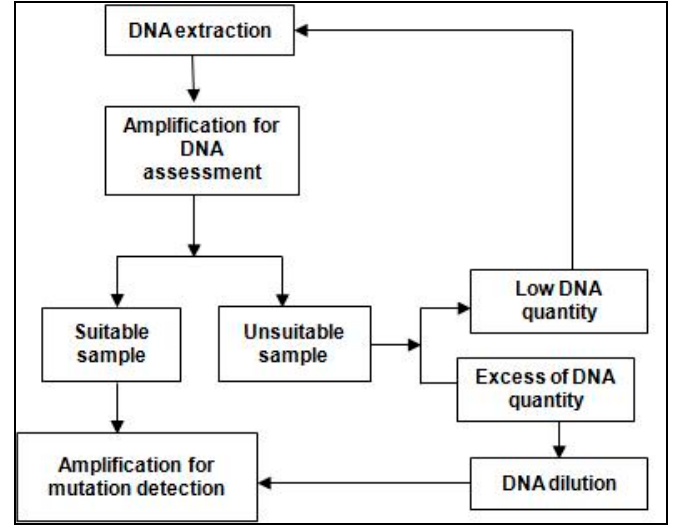
Figure 1. Workflow for screening of patient samples for EGFR mutations.